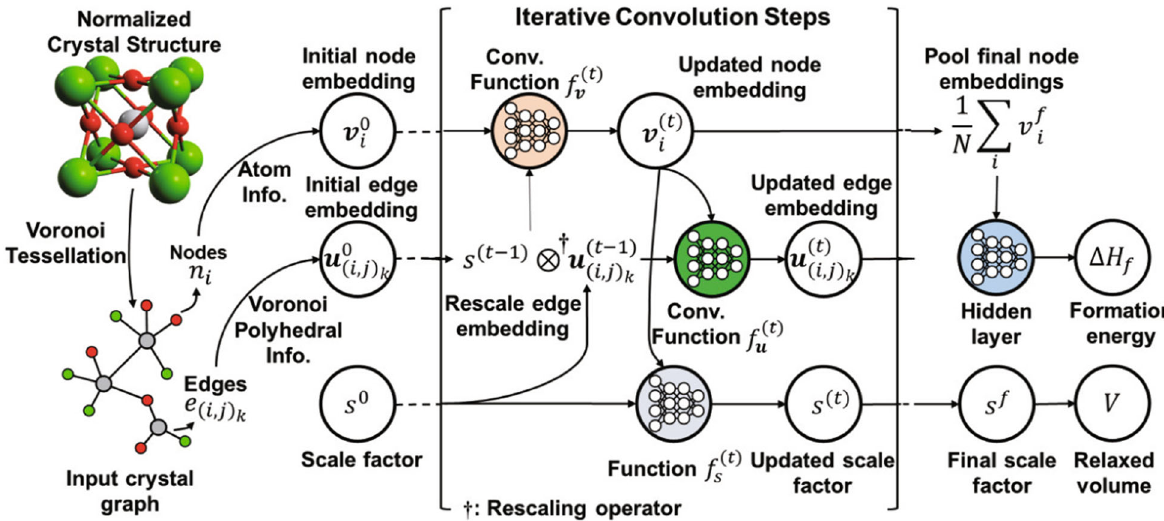
, that encode the atom k are also k